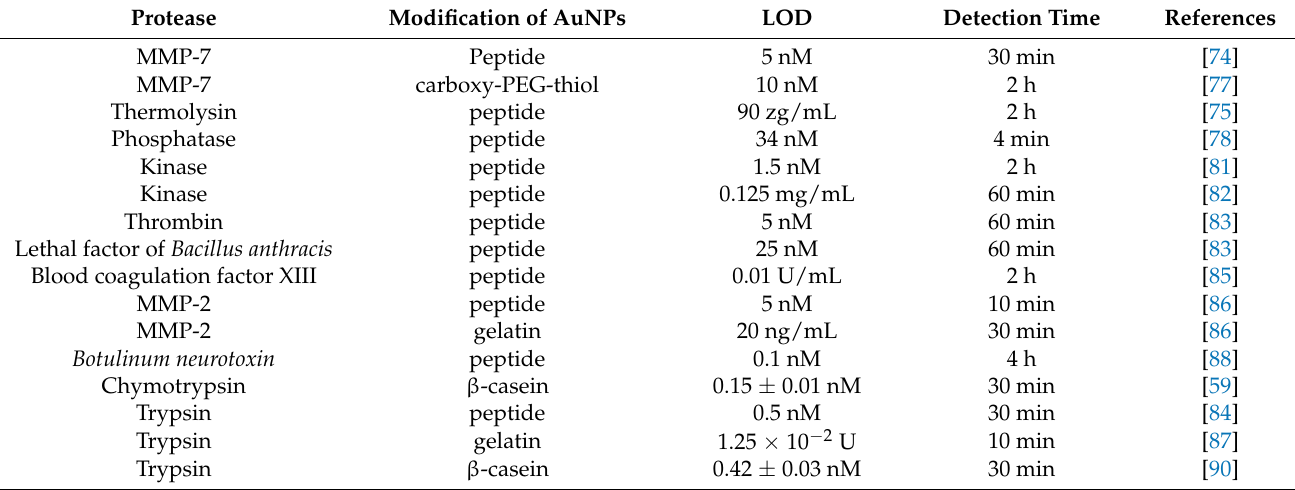
Table 3. Determination of enzymes and proteins by colorimetric methods based on AuNPs. Protease Modification of AuNPs LOD Detection